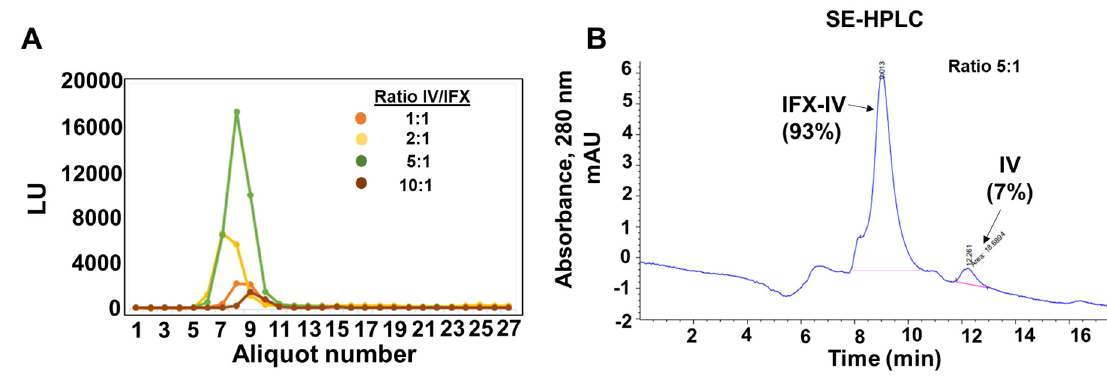
Figure 10. ( A ) Sephadex G25 chromatographic profiles of IFX-IV complexes. ( B ) SE-HPLC chromatographic profile of IFX-IV complex obtained at the ratio 5:1.